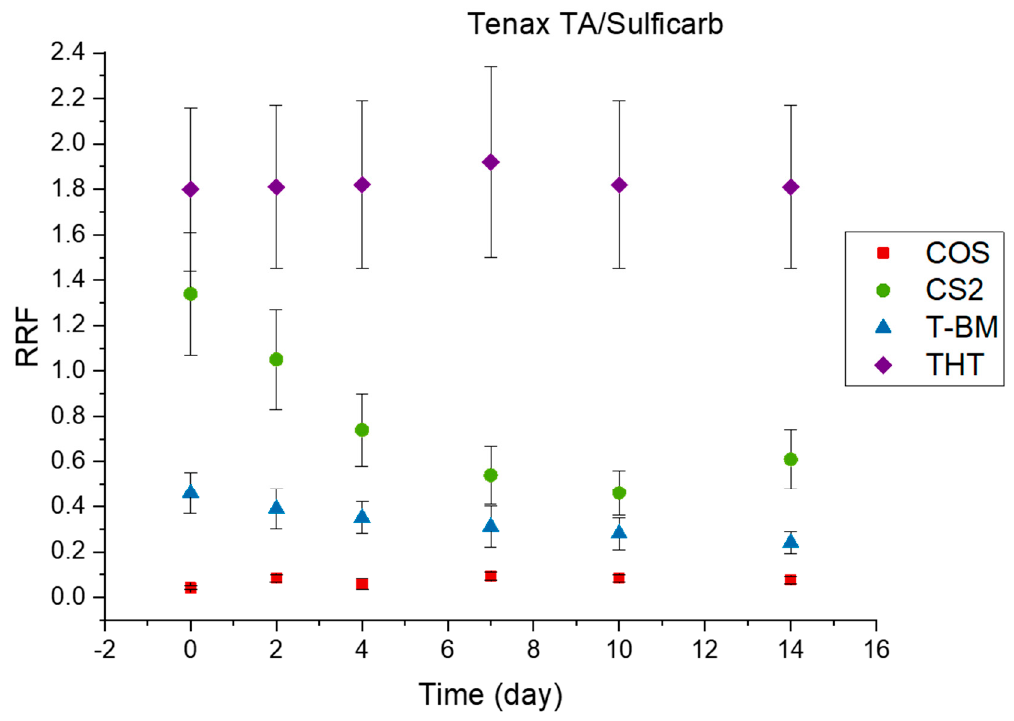
Figure 12. Storage stability of sulphur compounds (~20 nmol/mol) on Tenax TA/SulfiCarb.